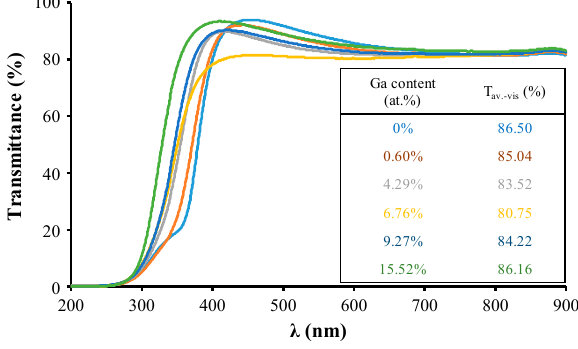
Figure 6. The variation in film transmittance as a function of Ga content in ZnO films.